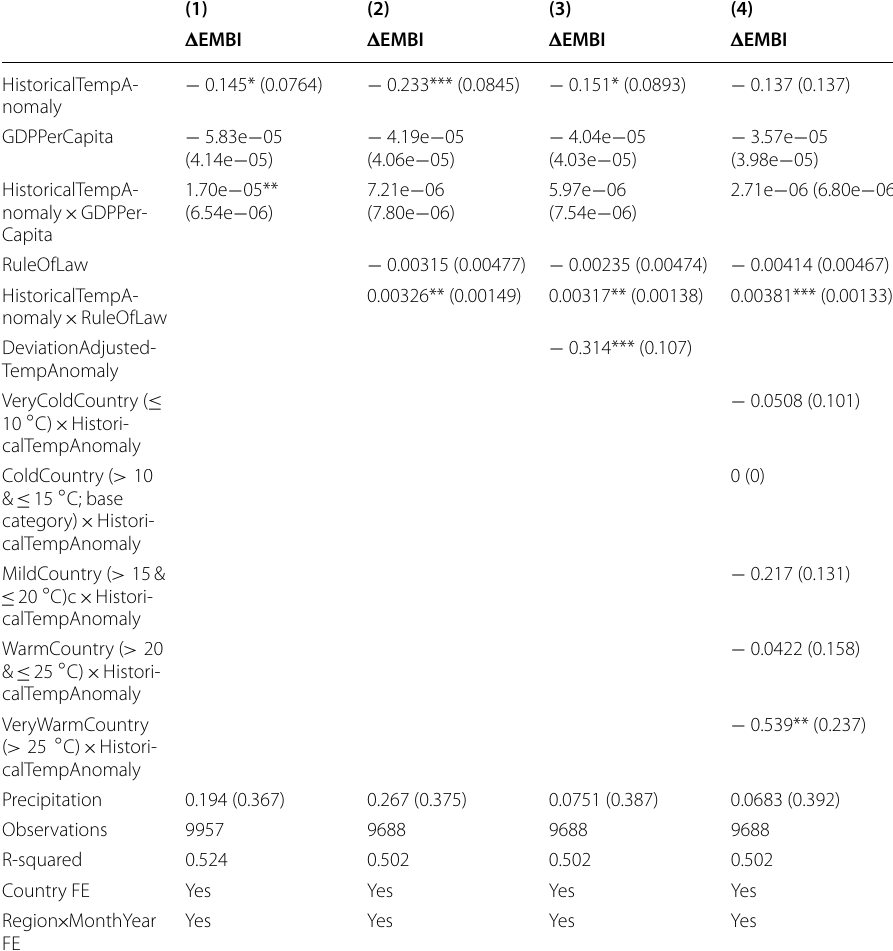
Table 11 Channels of temperature–sovereign risk connection: combining relevant channels